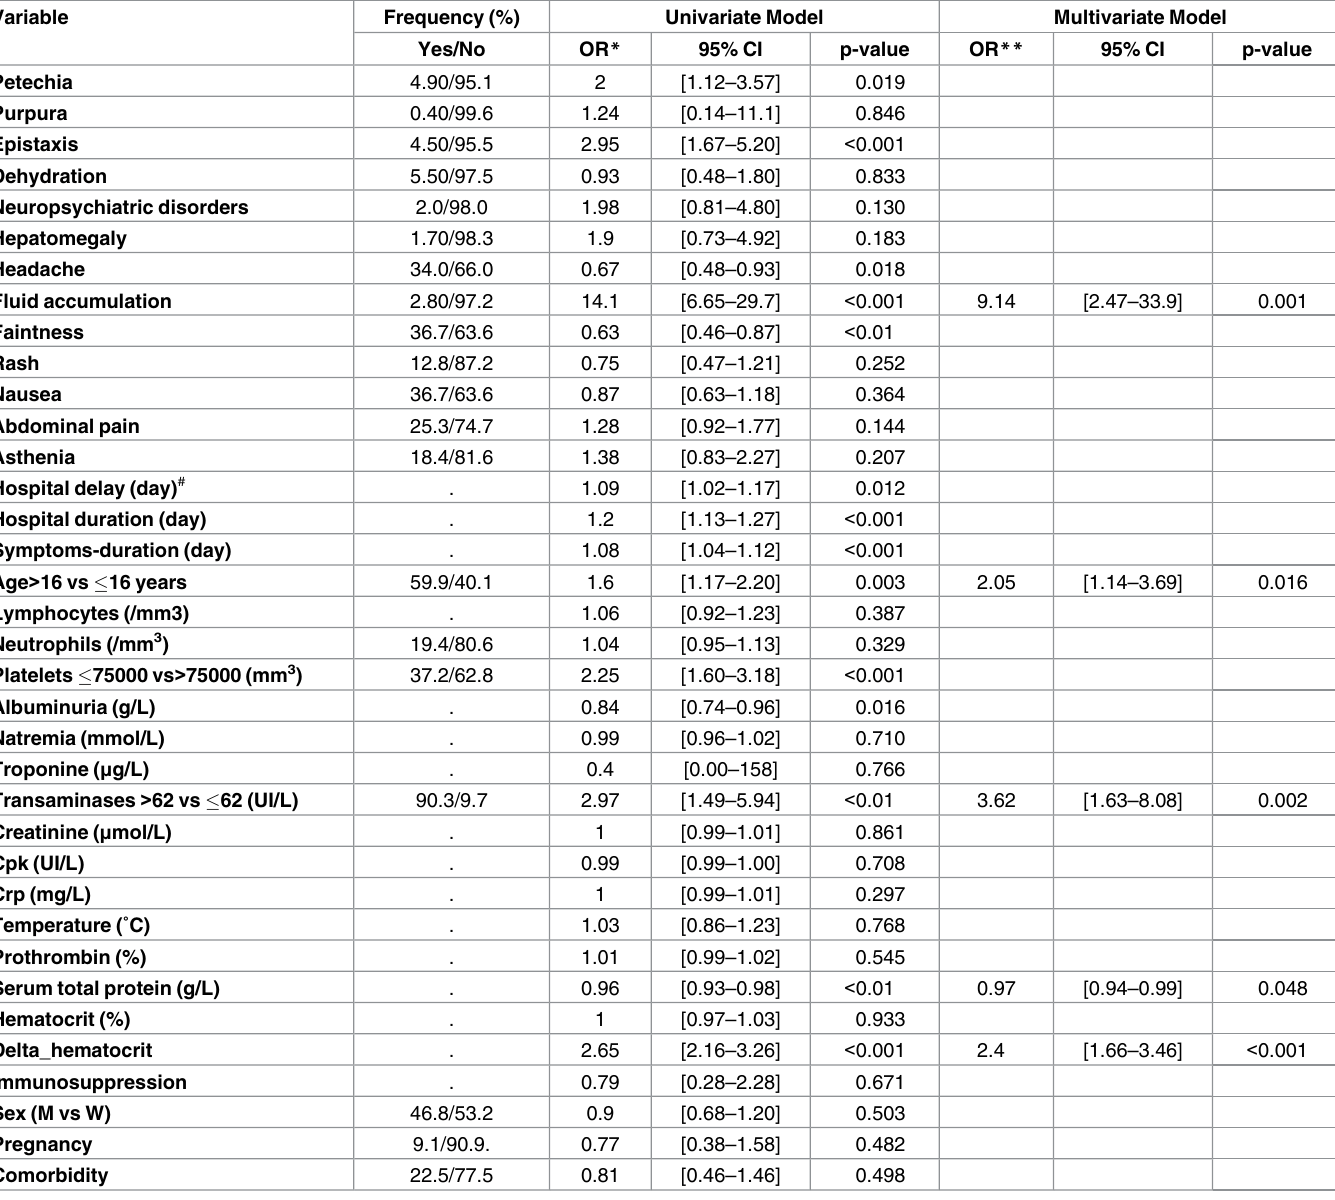
Table 3. Crude and adjusted associations between possible risk factors and development of severedengue disease using logistic